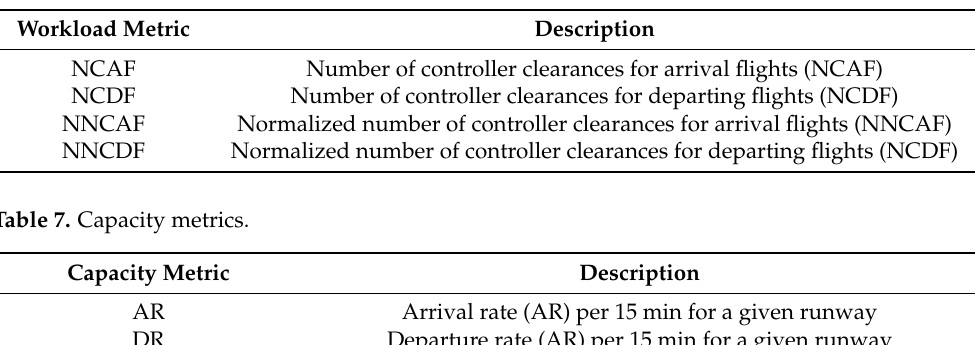
Table 6. Workload metrics.